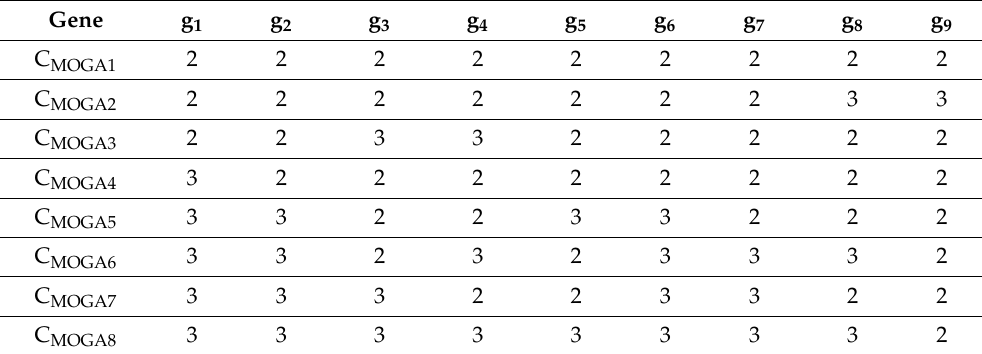
Table 1. Chromosomes belonging to the optimal Pareto front in Figure 6. The tray typology coding is: 1 = Bot, 2 = Mid, and 3 = Top.